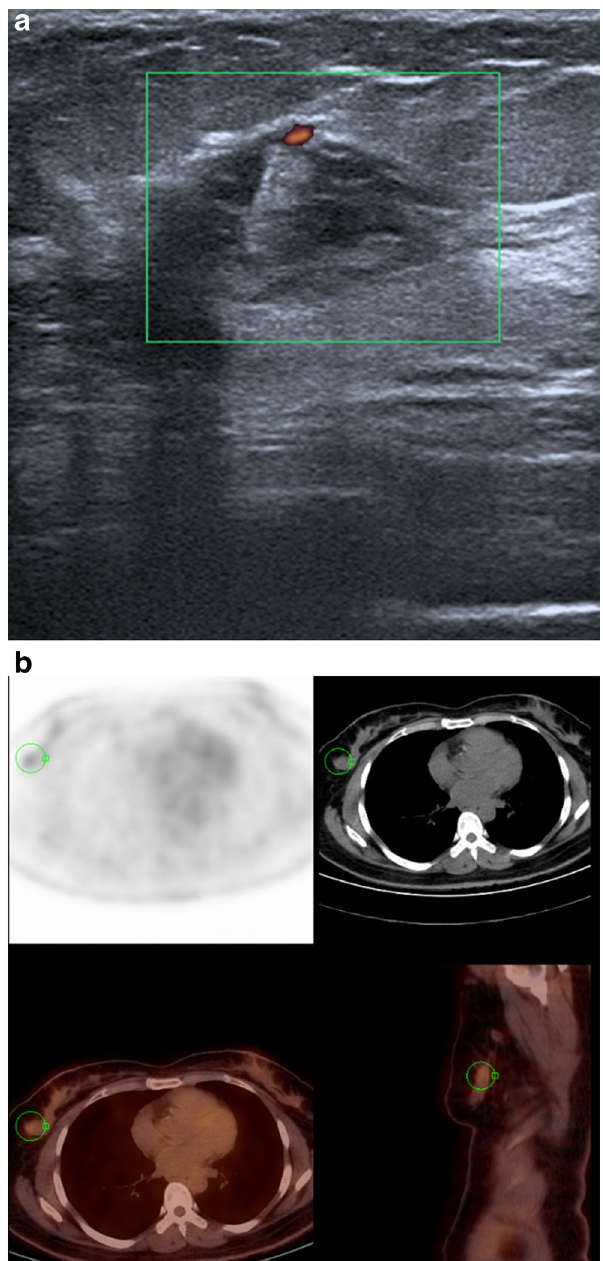
Fig. 19 Lymphoma. a Ultrasound of the right breast showing a poorly demarcated, mixed echogenicity mass, with blood flow on Doppler ultrasound. b PET-CT scan in this patient shows a hypermetabolic lesion in the right breast. Microbiopsy revealed diffuse large B-cell